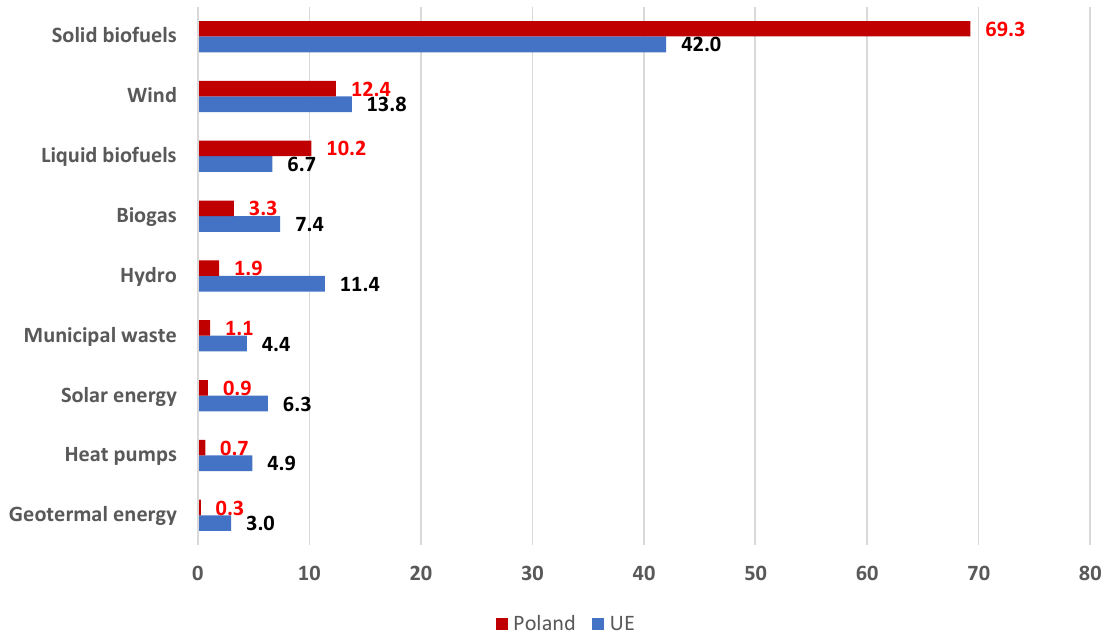
Figure 2. Kinds of energy obtained from renewable sources in Poland and in the EU by carriers in 2018 in relation to 100% primary energy production. Own study, based on [28].